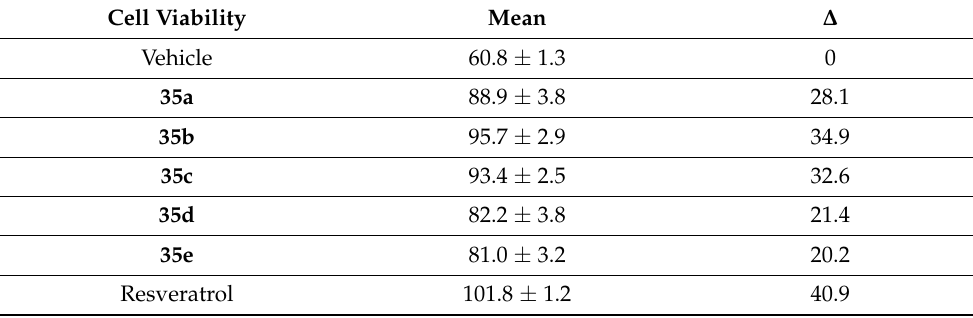
Table 4. Cell viability (%) from A β -induced neurotoxicity in primary rat cortical